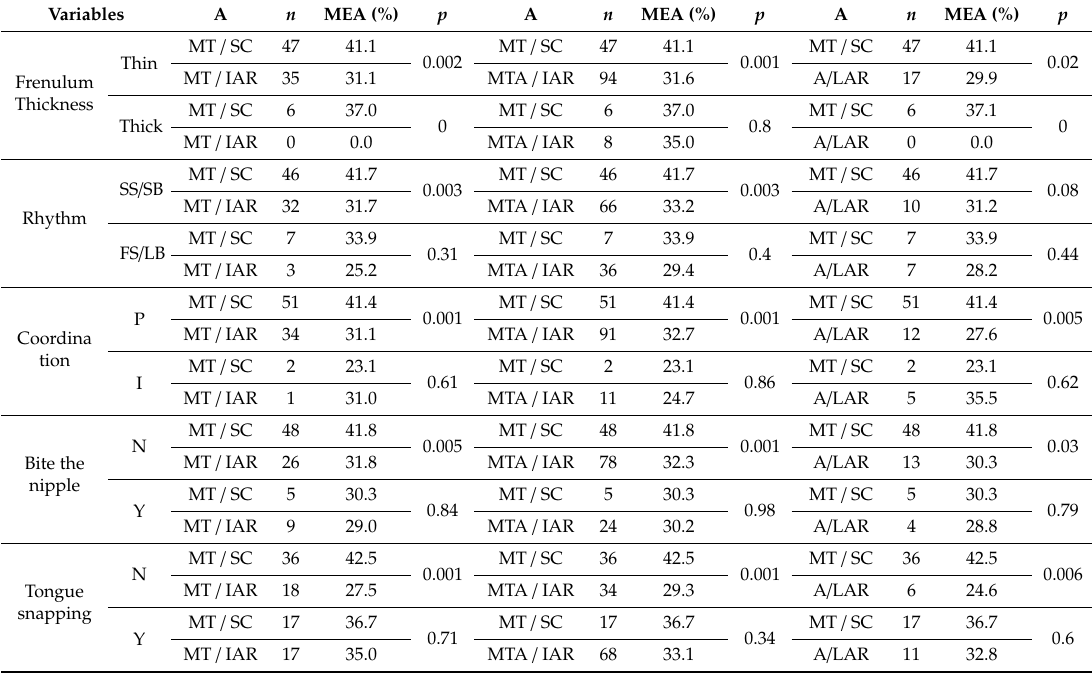
Table 3. Comparison of the MEA of the suprahyoid muscles of infants during breastfeeding according to thickness, frenulum attachment to the tongue and floor of the mouth (MT / SC and MT / LAR; MT / SC and MTA / LAR; MT / SC and A / LAR), and nutritive sucking